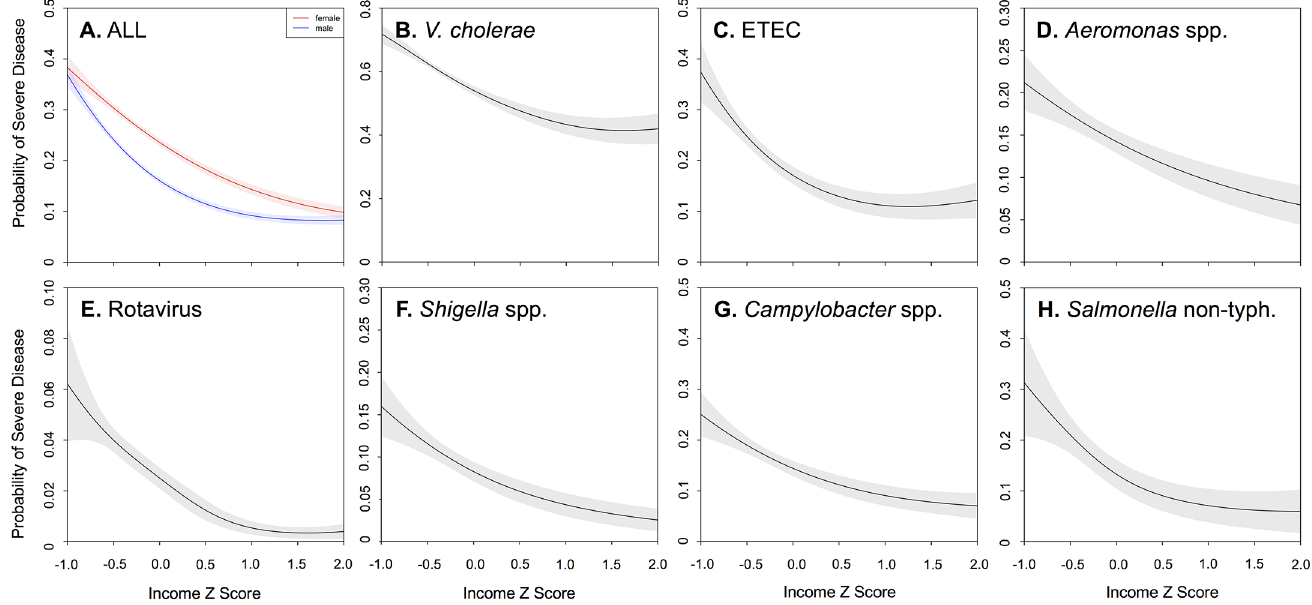
Fig 4. Predicted probability of severedehydration as a function of family income Z score, by pathogen. Panel A shows sex-stratified risks as a function of income Z score for all patients (male = blue, female = red). Shadingrepresents the 95% confidenceinterval. Remainingpanels(B-H) show risk as a function of income Z score for specific pathogens.